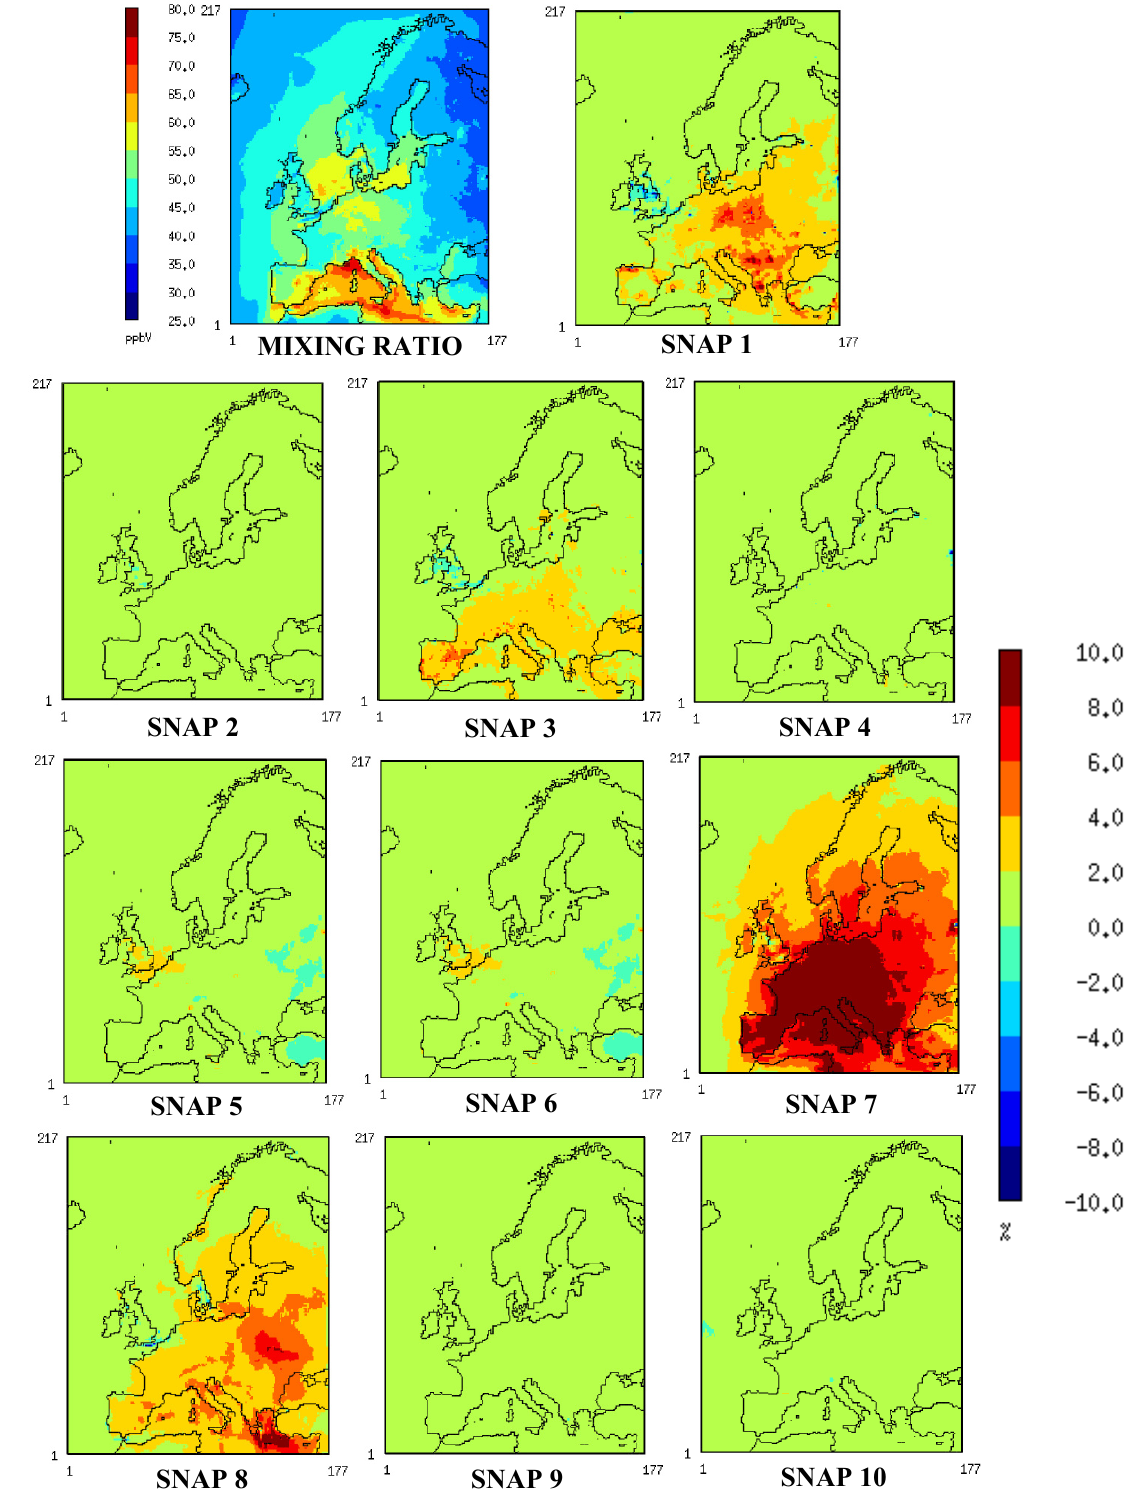
Figure 3. Daily average Max8hrO 3 mixing ratio for July 2006 and the impact of each SNAP